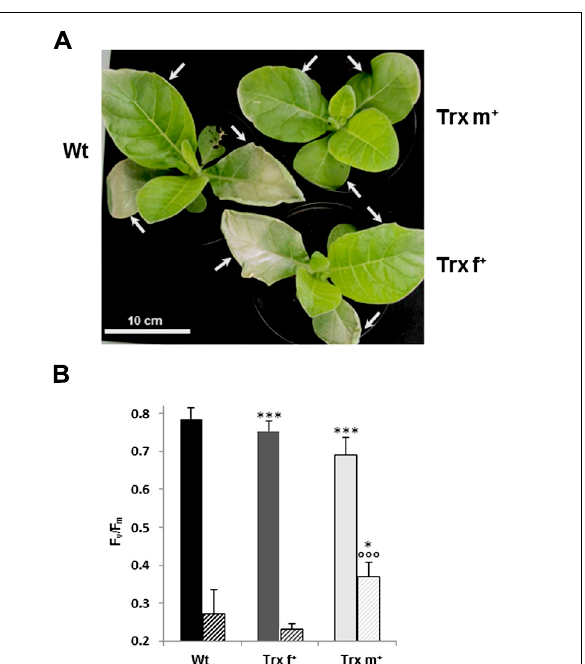
FIGURE 5 | Glutathione and ascorbate content in transplastomic tobacco plants overexpressingTrx f orTrx m. Total content (A, C) and redox status (B, D) of glutathione (A, B) and ascorbate (C, D) were determined in leaves of tobacco plants grown in standard conditions for 40 days. Measurements were performed using HPLC as described in Section “Materials and Methods” using three 1-cm leaf disks from young well-expanded leaves. Data are mean values ± SD from at least 10 independent measurements per genotype.Wt, wild-type;Trx f + andTrx m + , plants overexpressingTrx f orTrx m, respectively.Values significantly different fromWt values with ** p < 0.01 and *** p < 0.001 ( t -test).